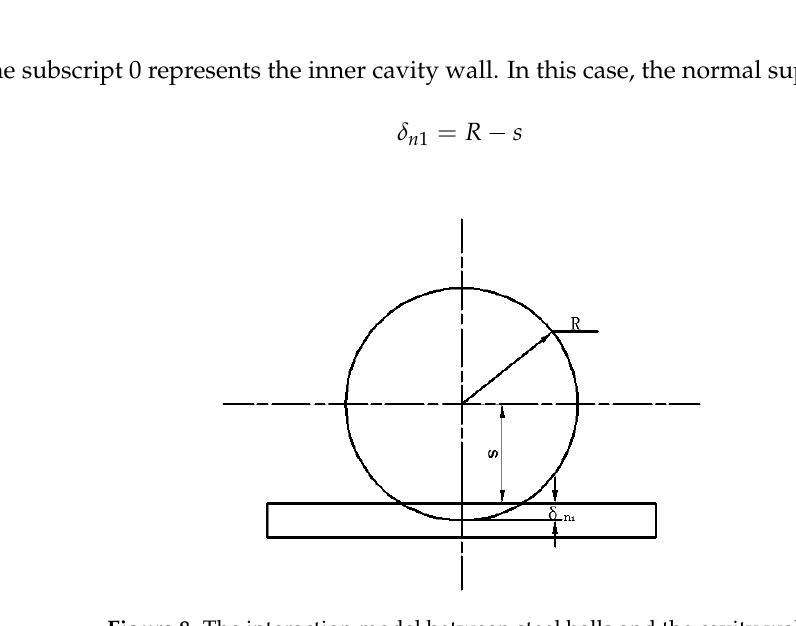
Figure 8. The interaction model between steel balls and the cavity wall.